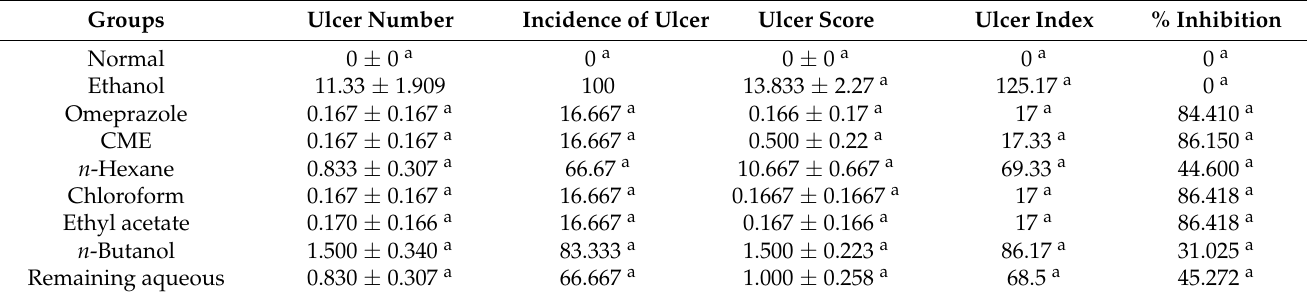
Table 3. Antiulcer effect of H. crispum CME and different fractions on different gastric